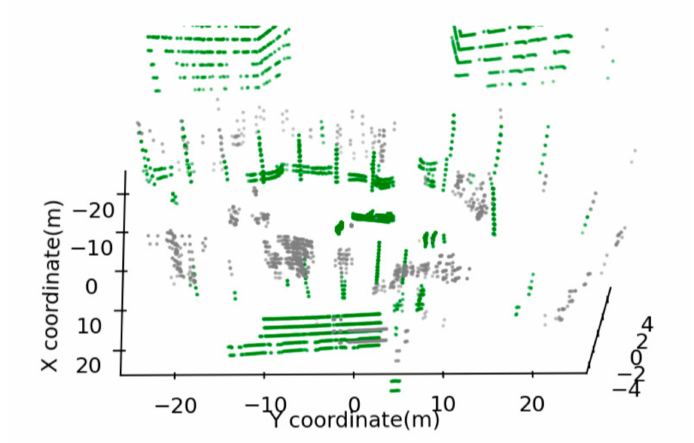
Figure 8. 3D display of major parts of point cloud after modifying Error 1 and Error